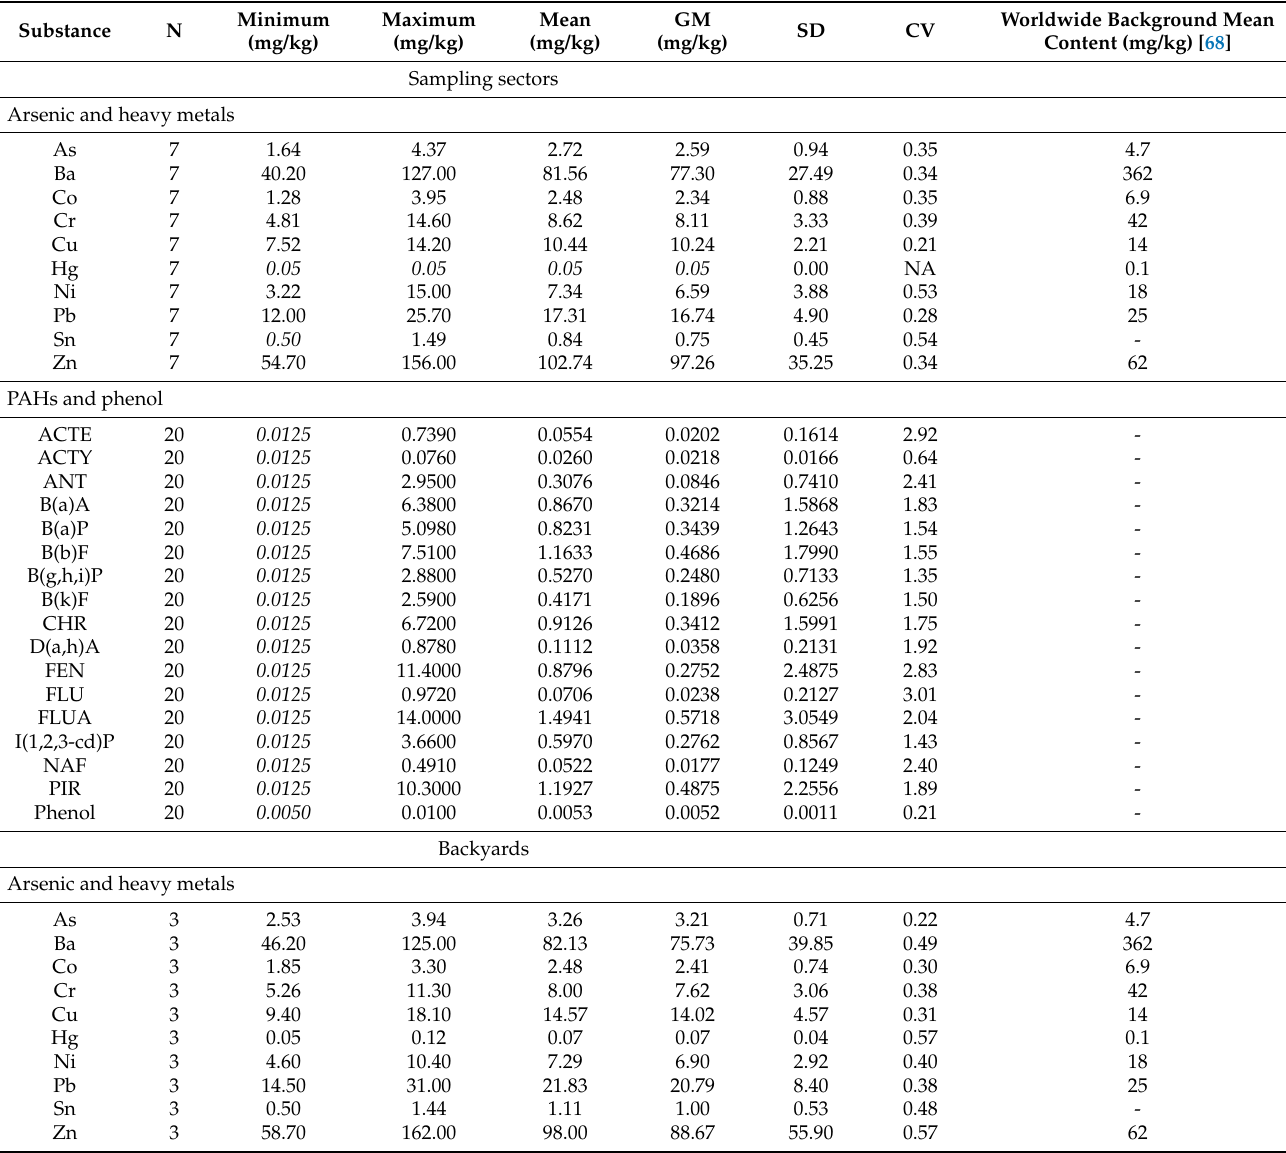
Table 7. Descriptive statistics of substances analysed in sectors and